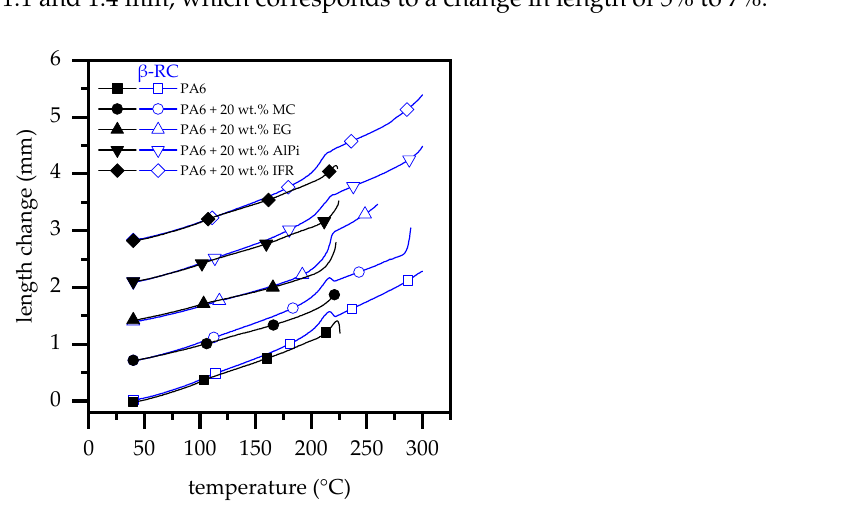
Figure 9. Longitudinal length change tracked during torsion DMA measurements for β‐ RC samples; 1 Hz; 0.05% strain.